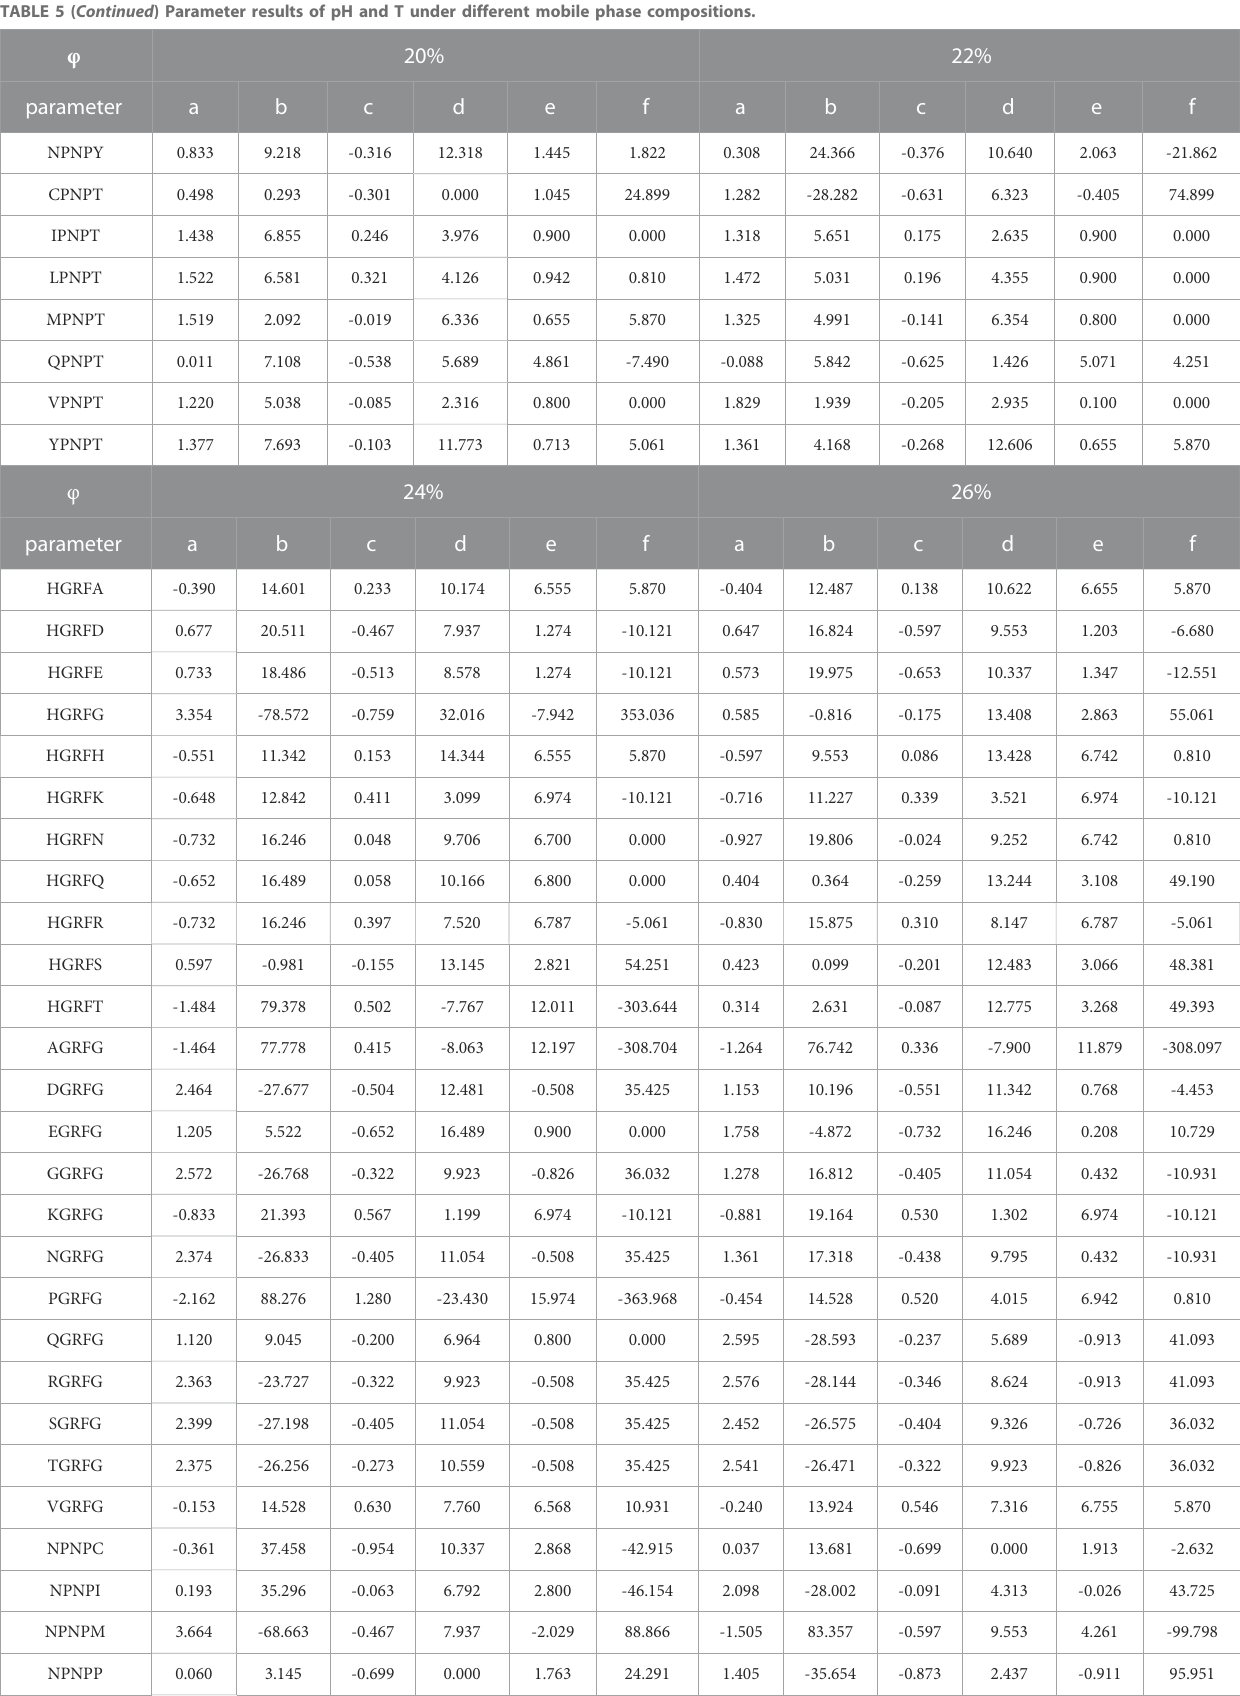
TABLE 5 ( Continued ) Parameter results of pH and T under different mobile phase